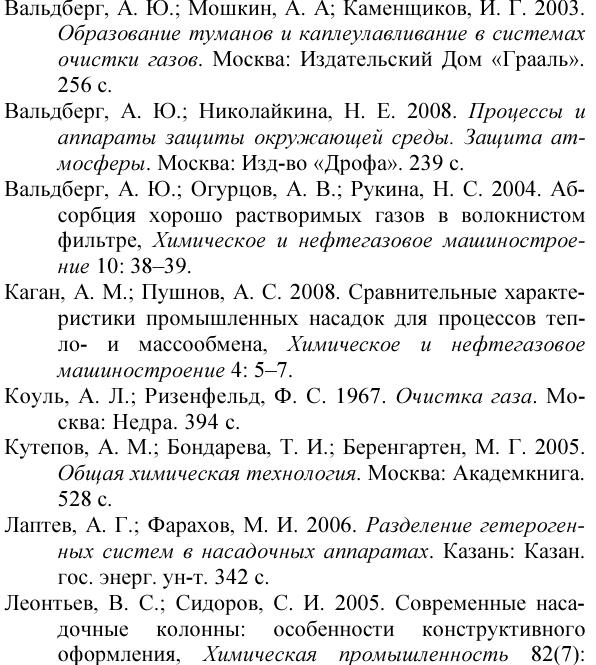
Fig. 8. Dependence of notional volume ratio of absorption on concentration of СО 2 at the apparatus inlet under inte- grated irrigation: one horizontal and three vertical nozzles 3 3 m ( g ν = 1.37 m/s, = 0.0038 m /m